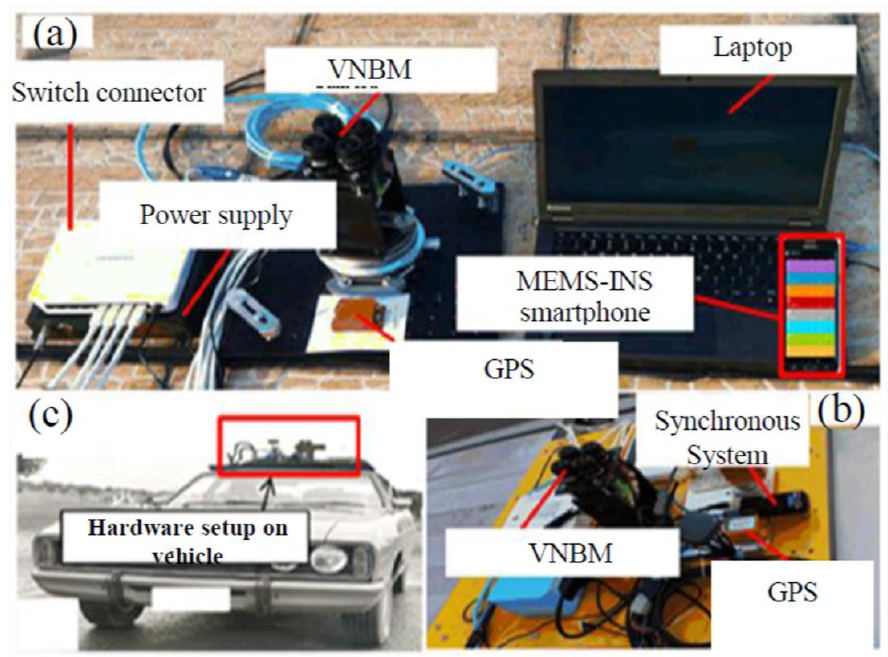
Figure 7. Description of hardware used: ( a ) hardware components, ( b ) hardware connection system, ( c ) hardware setup on vehicle.